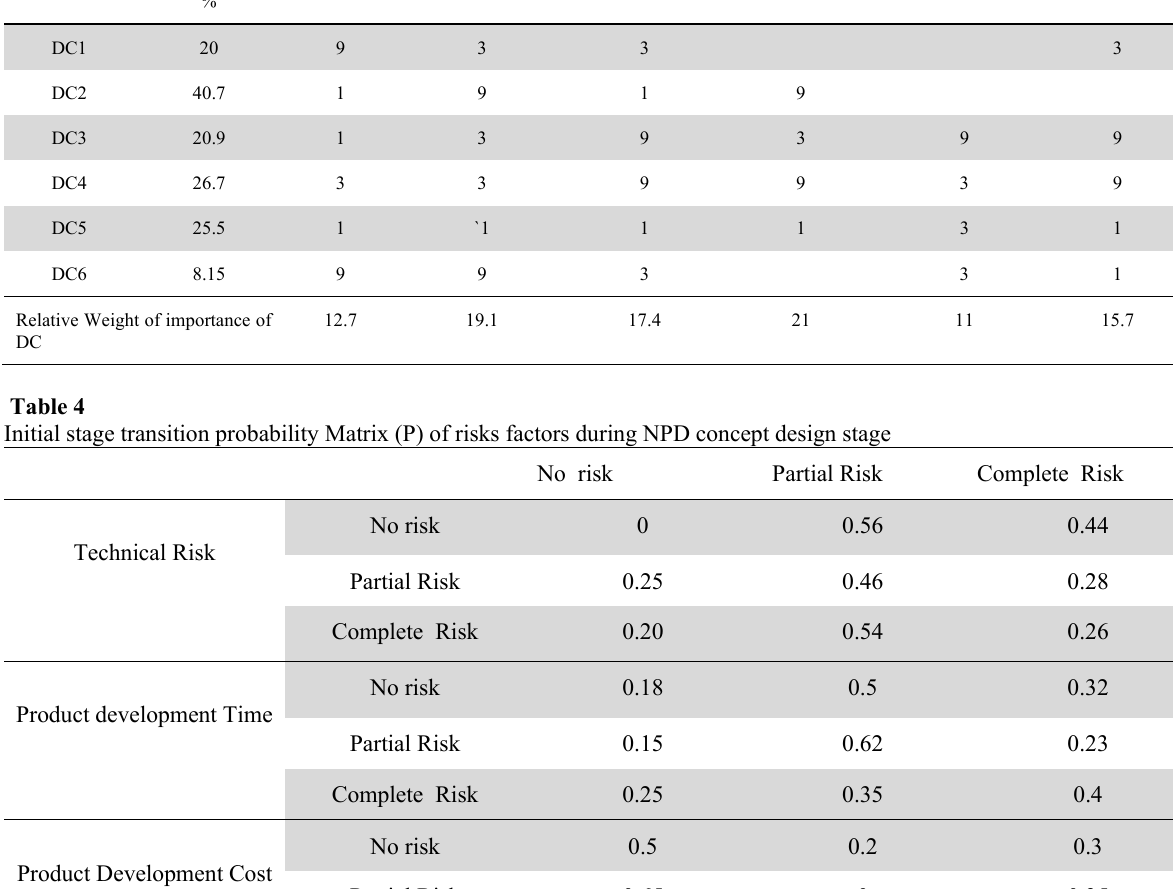
Design characteristics to complete design solutions mapping Relative weight